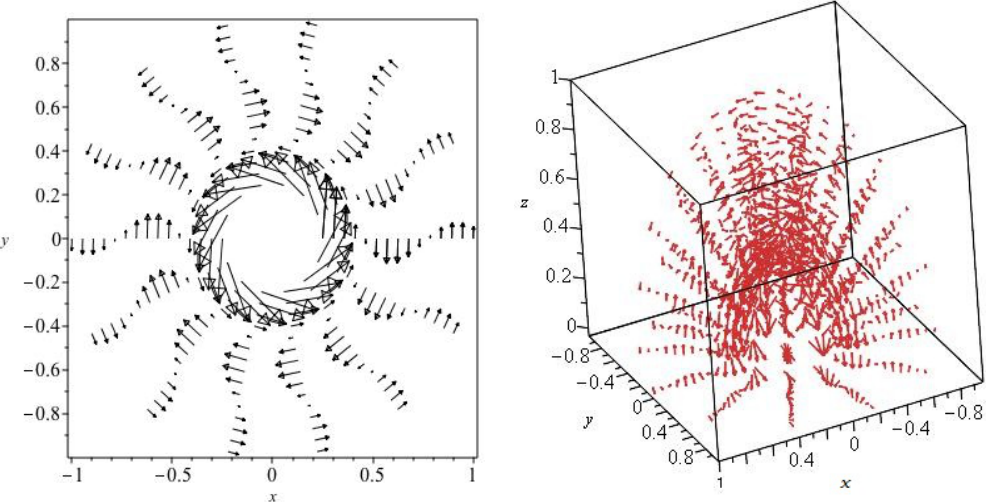
Figure A1. At upper right the linear force-free field is shown in three dimensions with { C 1, C 2, C 3, q , Φ } = { 1,1,1,10,0 } . The field winds around the axis and the dome like structure oscillates in direction. The radius has been integrated from 0.35 to 1. On the left the toroidal field is shown wound on a cone with opening angle of 60 ◦ relative to the polar axis. The radius is integrated over 0.25 ≤ r ≤ 1. Reversing toroidal field lines are